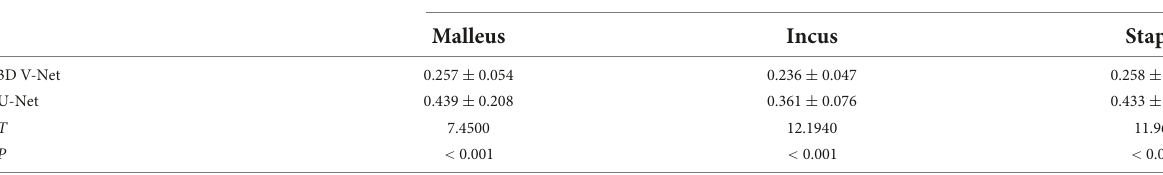
TABLE 4 Comparison of ASD between automatic segmentation and manual segmentation under two neural networks. Network structure